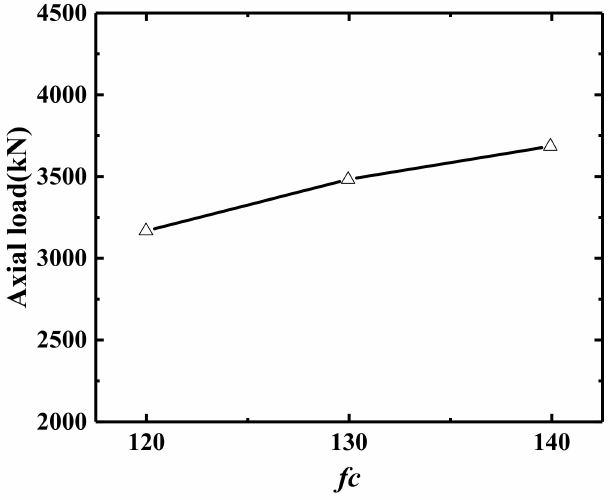
Figure 21. Variation of ultimate bearing capacity of different concrete strength